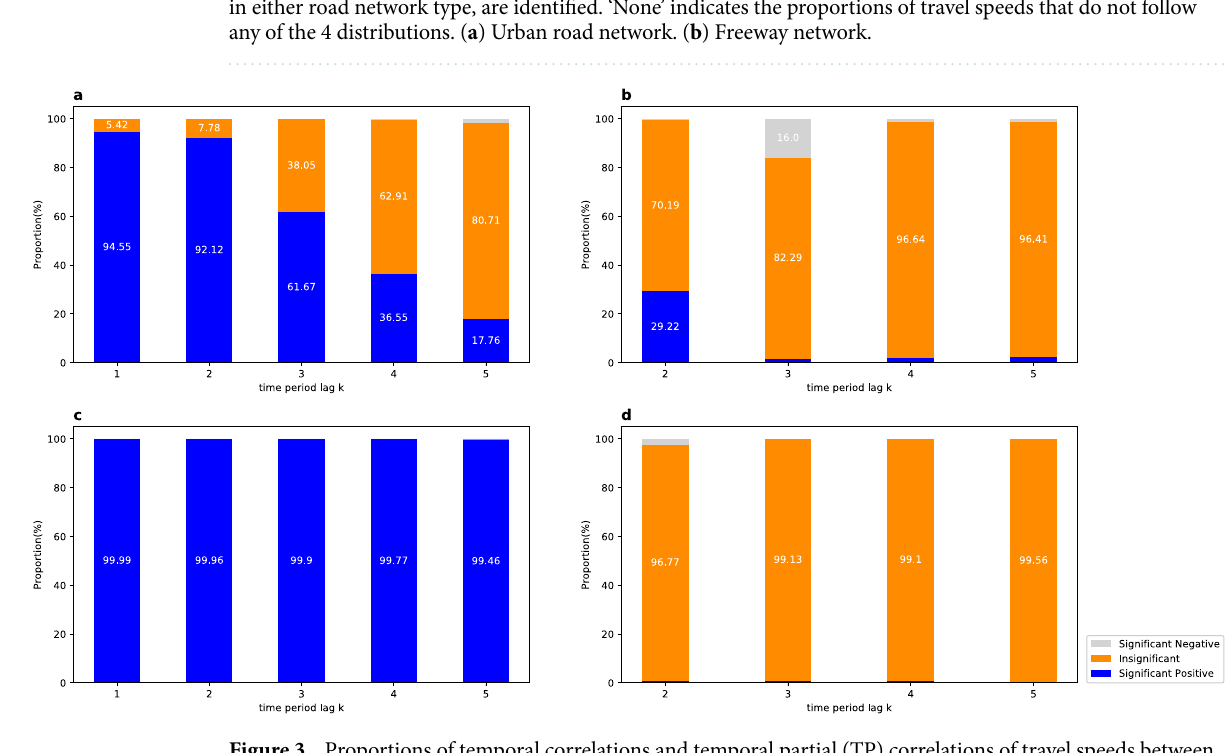
Figure 3. Proportions of temporal correlations and temporal partial (TP) correlations of travel speeds between period i and period i + k ( k = 1, 2, . . . 5 ) . The three colors in each bar represent the average proportions from different time ranges at a specific time period lag, for significant positive, insignificant, and significant negative temporal or TP correlations, respectively. We provide the average results of different time ranges here because different time ranges have little effect on the results of temporal and TP correlations (see Supplemental Tables S2 and S3). ( a ) Urban road network (temporal). ( b ) Urban road network (TP) . ( c ) Freeway network (temporal). ( d ) Freeway network